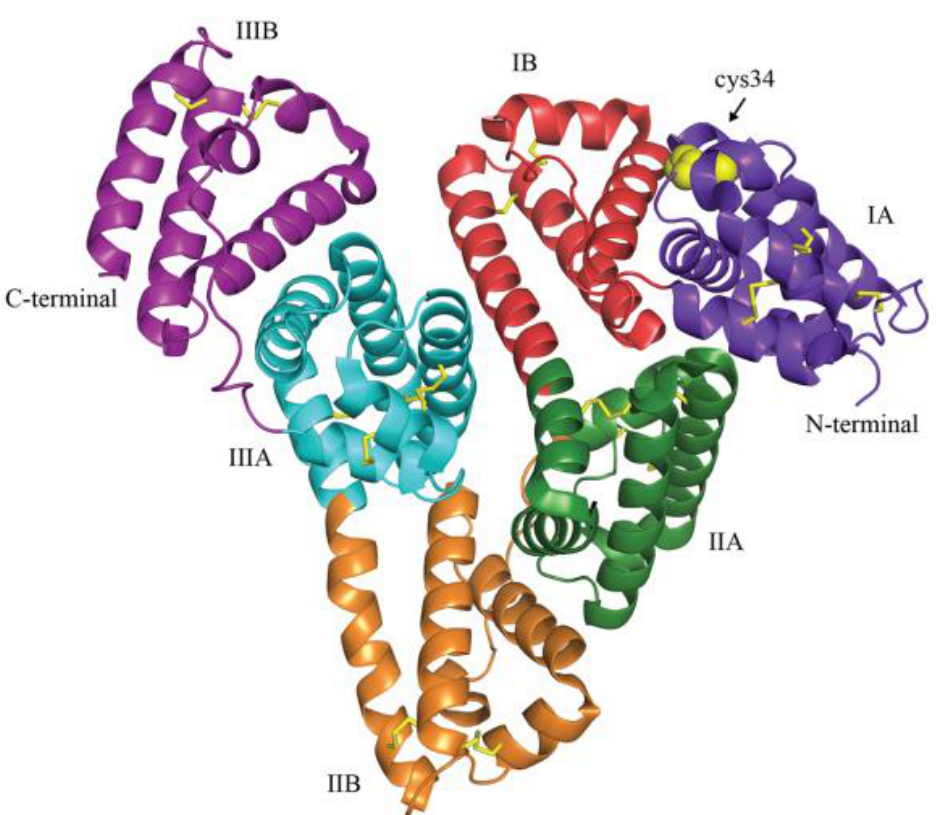
Figure 2. Illustration of the tertiary structure of human serum albumin. The three domains of albu- min are shown in purple (IA), red (IB), green (IIA), orange (IIB), blue (IIIA), and violet (IIIB). Yel- low sticks depict disulfide bridges, and yellow spheres highlight the available cysteine 34 in do- main IA. Reproduced without modification from Larsen et al. 2016 [34], under a Creative Com- mons Attribution 4.0 International (CC BY 4.0) License (https://creativecommons.org/li- censes/by/4.0/ (accessed on 25 April 2021)). No copyright, as the Creative Commons Public Do- main Dedication waiver (https://creativecommons.org/publicdomain/zero/1.0/ (accessed on 25 April 2021)) applies. This reuse has not been endorsed by the original authors. The source refer- ence is “Albumin-based drug delivery: harnessing nature to cure disease” in Mol Cell Ther and is available at https://molcelltherapies.biomedcentral.com/articles/10.1186/s40591-016-0048-8 (ac- cessed on 25 April 2021).